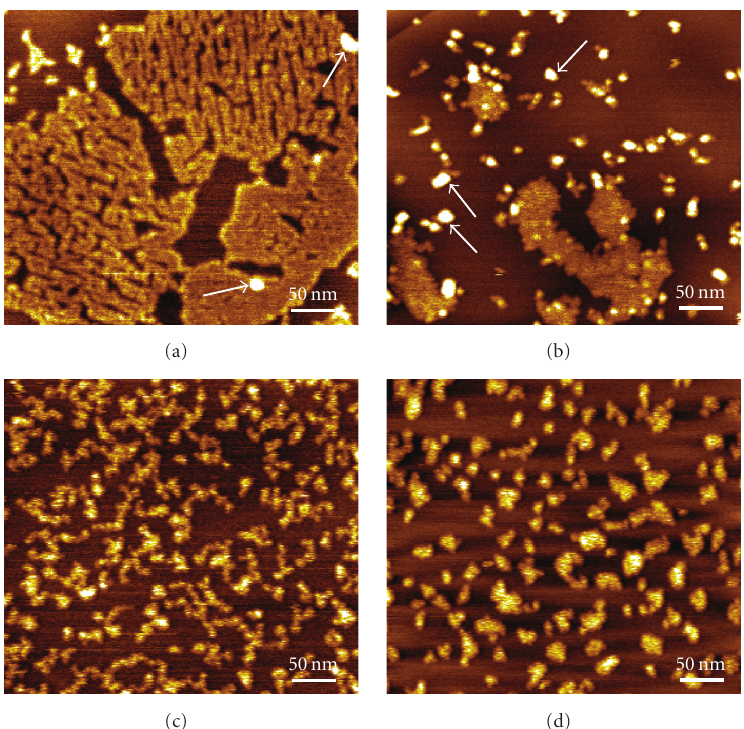
Figure 1: AFM topographical images in air of TBA molecules, immobilized onto HOPG by spontaneous adsorption during 3 minutes, from solutions of 1 μ gmL − 1 TBA in pH 7.0 0.1 M phosphate bu ff er: (a, b) in the absence and (c, d) in the presence of 100 mMK + , after (c) 1 hour and (d) 24 hours of